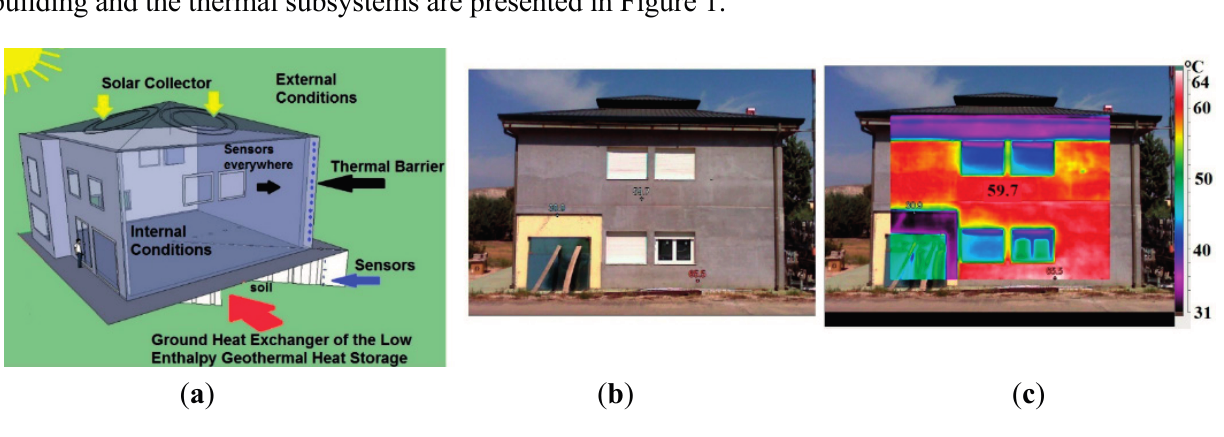
Figure 1. ( a ) Scheme of the nZEB building with the solar collector, the low enthalpy geothermal subsystem and the dynamic thermal barrier; ( b ) Building prototype; ( c ) Thermal image of the nZEB South